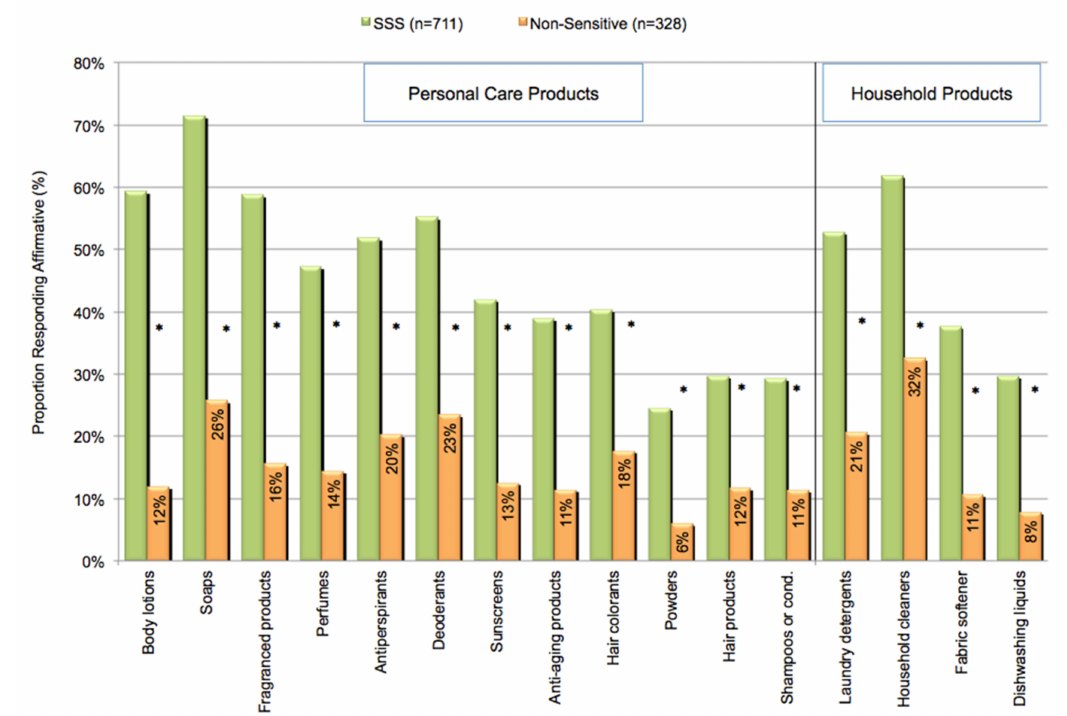
Figure 4. Household and personal care product categories reported to trigger SSS symptoms. Responders in the Cincinnati study were asked if a variety of categories of household and personal care products had ever caused adverse reactions to their skin [7,80]. For all product categories, the proportion of SSS individuals who responded positively was significantly higher than the number of non-SSS individuals who responded positively. (* = p < 0.00001).